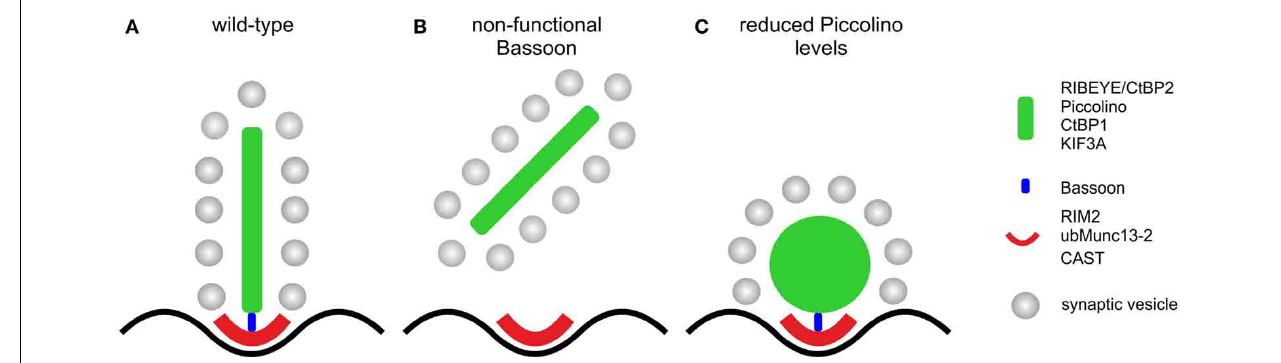
FIGURE 8 | Schematic illustration of the effect of the absence of Bassoon and Piccolino on the structure of the rod photoreceptor ribbon synaptic complex. (A) Plate-shaped and anchored ribbon in a wild-type rod photoreceptor synapse. (B) Free floating ribbon in a Bassoon-mutant rod photoreceptor synapse. (C) Membrane attached